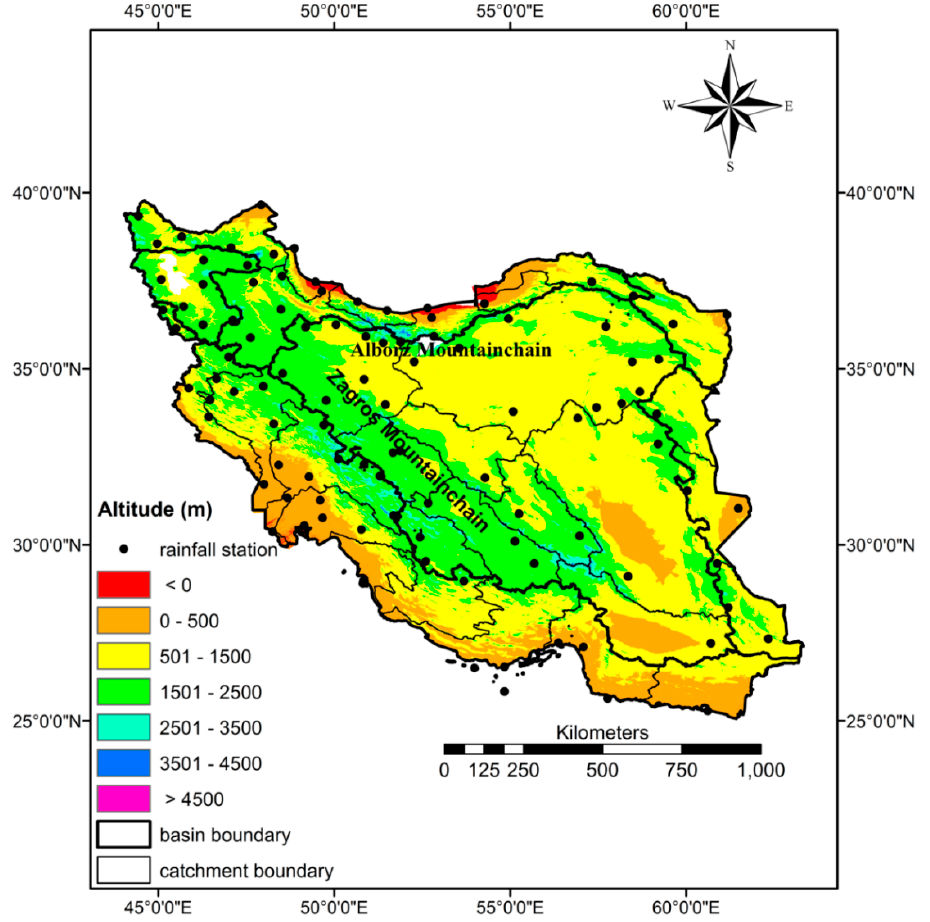
Figure 1. Location map of study region and synoptic stations. Table 1. Large-scale climate circulation indices classification. The x denotes the value of each index.